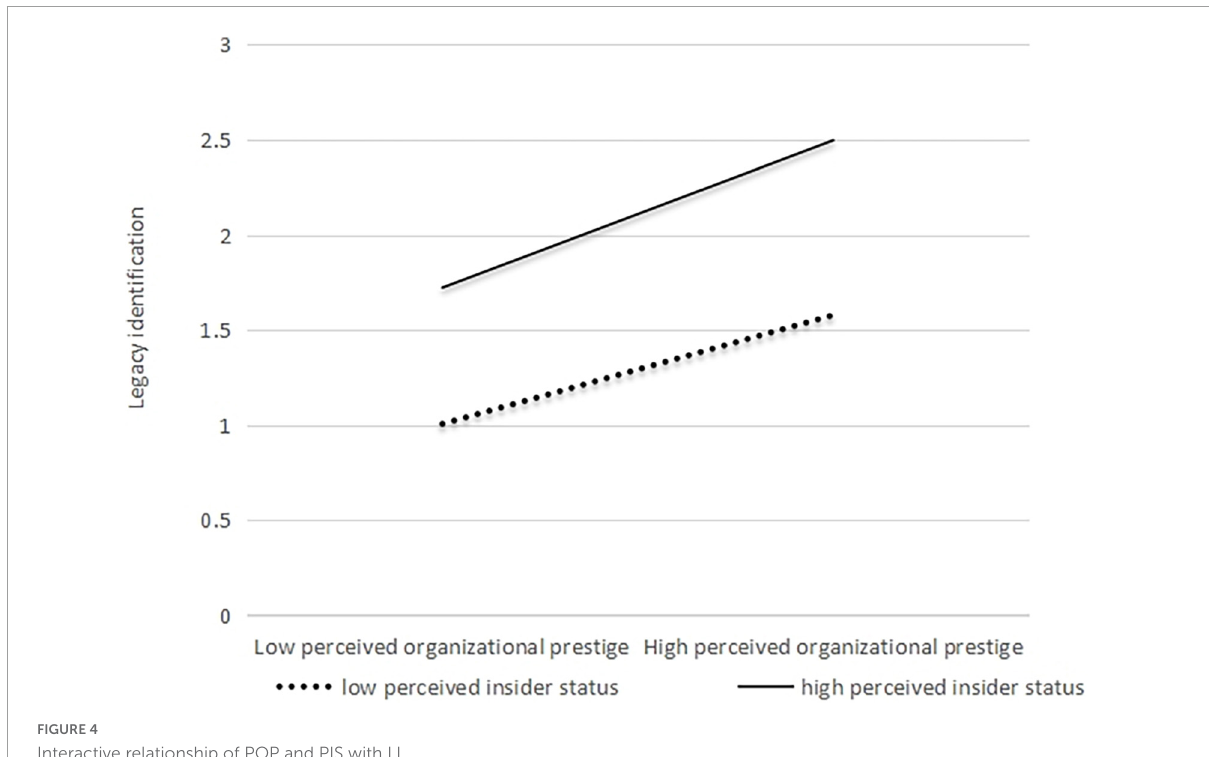
FIGURE4 Interactive relationship of POP and PIS with LI.